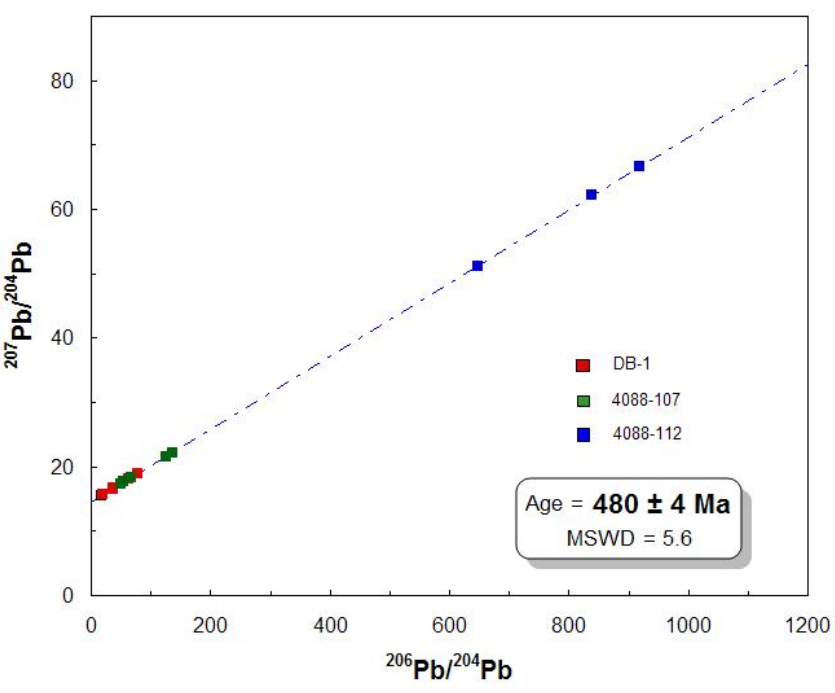
Figure 13. Diagram in coordinates 206 Pb/ 204 Pb– 207 Pb/ 204 Pb for cassiterite of the Yaroslavskoe and